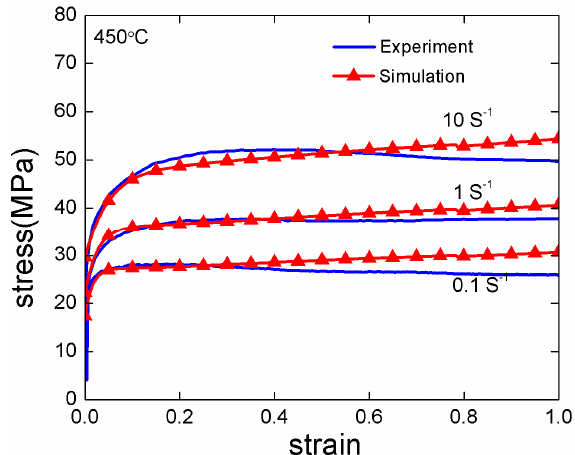
Figure 8. Initial textures obtained by EBSD at the beginning of the three flow lines.